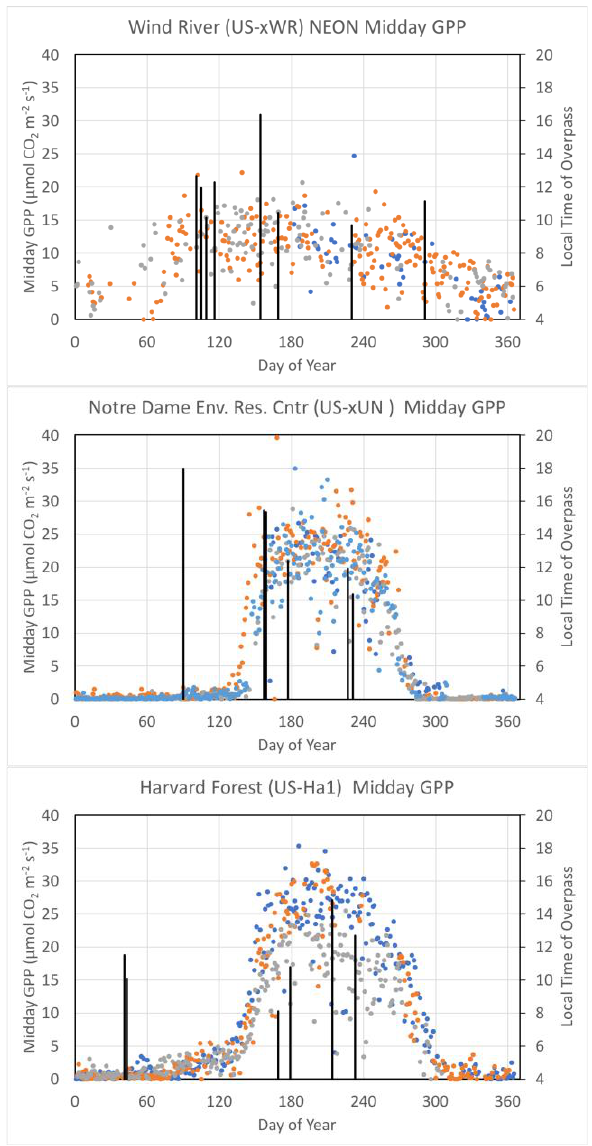
Figure 1 . Seasonal patterns of midday average GPP for the three study sites, with blue points from 2018, orange points from 2019 and grey points from 2020. Vertical black lines indicate days of DESIS image collection. The height of these lines indicates the time of day of the overpass. Upper plot shows data for Wind River Experimental Forest (US-xWR), the middle plot has data for University of Notre Dame Environmental Research Center (US-xUN), and the bottom plot shows data for Harvard Forest